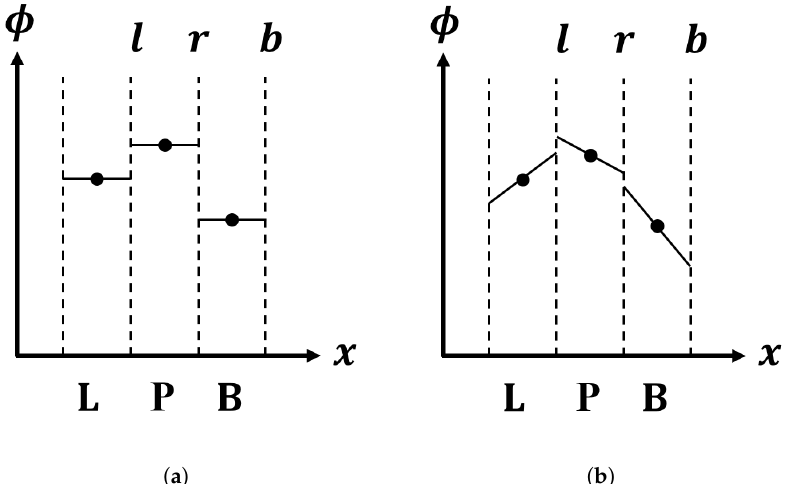
Figure 4. ( a ) Piecewise constant profile and ( b ) piecewise linear profile for reconstructed distributions of a scalar variable φ within cells. L , P , and B denote cells. l and r denote internal faces between cells while b is a boundary